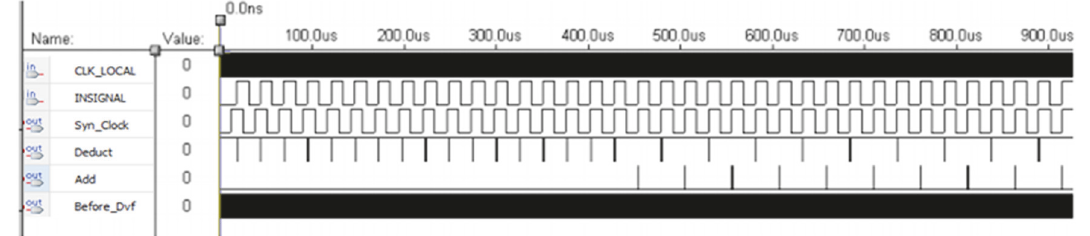
Figure 13: System simulated results without digital filter. CLK LOCAL: the local clock, INSIGNAL: the input signal, Syn Clock: the synchronization clock, Deduct: the leading control pulse of PD, Add: the lagging control pulse of PD, and Before Dvf: control module output/frequency divider input.